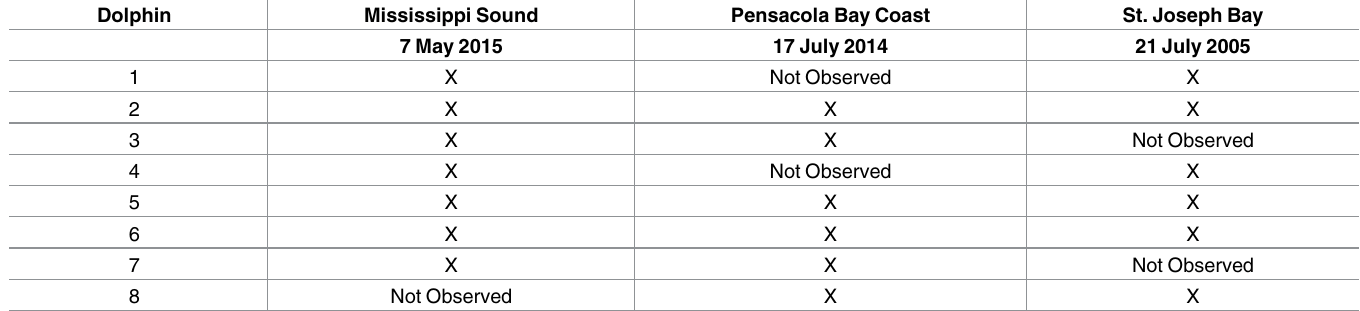
Table 2. Dorsal fin matches for bottlenose dolphin sightings associatedwith severedcatfish heads. X = dorsal fin match. Dolphin